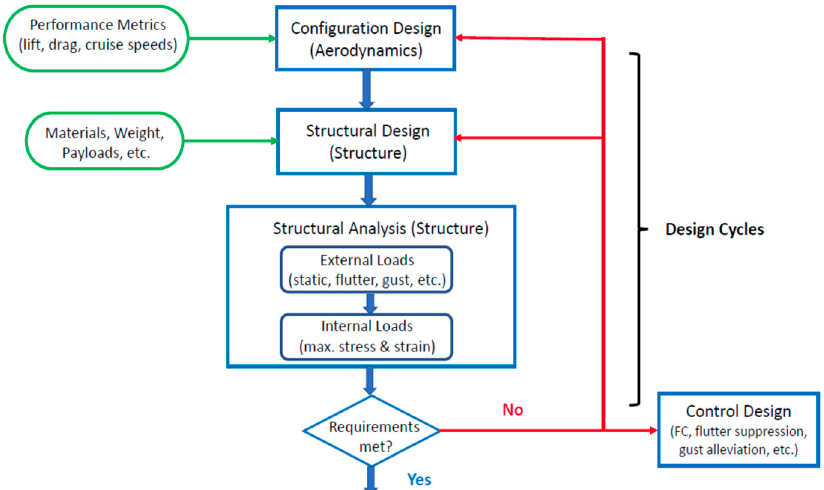
Figure 1. Flowchart of aircraft design and analysis cycle (image courtesy of J.T. Kim).